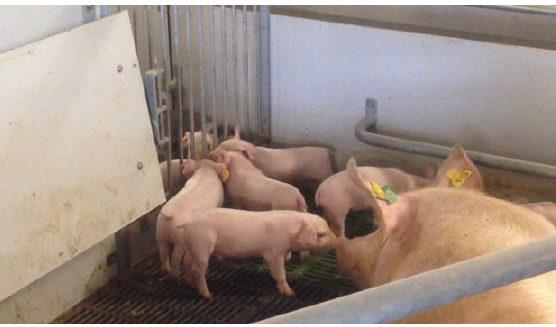
Figure 2 . A metal-barred gate installed between the adjacent SWAP pens.